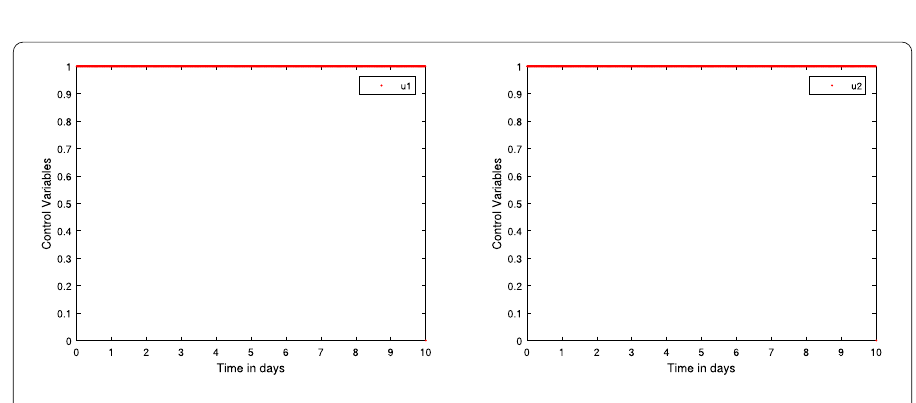
Figure 6 Profiles for the behavior of control variables u 1 and u